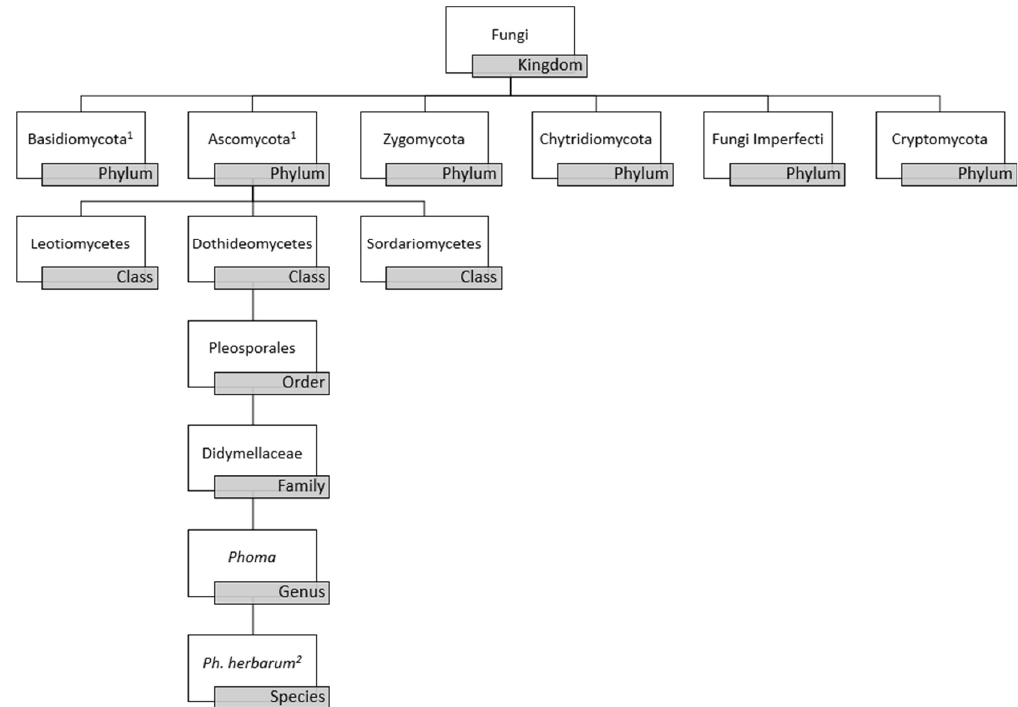
Figure 1. Phoma species schema based on current classification data utilizing morphologic and molecular characterization data. (1) Basidiomycota and Ascomycota are more closely related to one another than to other phyla. (2) Use of molecular based phylogenetic analyses has restricted the Phoma genus to Phoma herbarum sp. within family Didymellaceae.